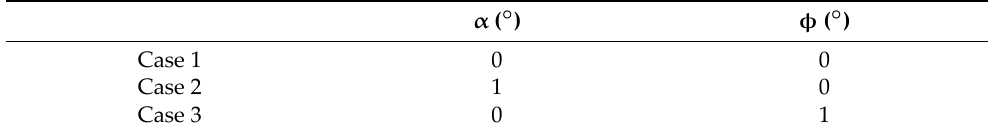
Table 4. α and ϕ in the CFD